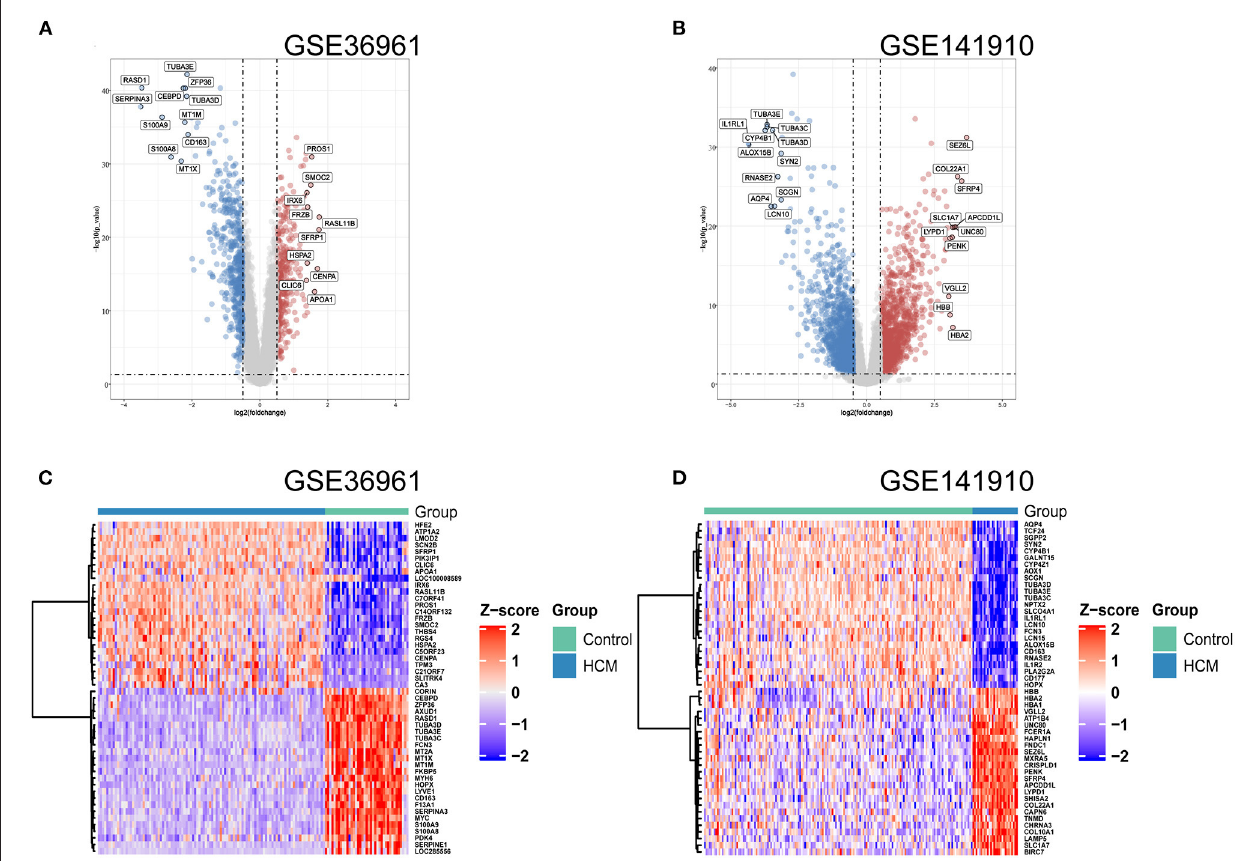
FIGURE 2 | Differentially expressed genes (DEGs) of used datasets. (A,B) Volcano plot of DEGs between HCM and healthy control cardiac tissues in GSE36961 and GSE141910. (C,D) Heat maps of potential DEGs between HCM and healthy control cardiac tissues in GSE36961 and GSE141910.